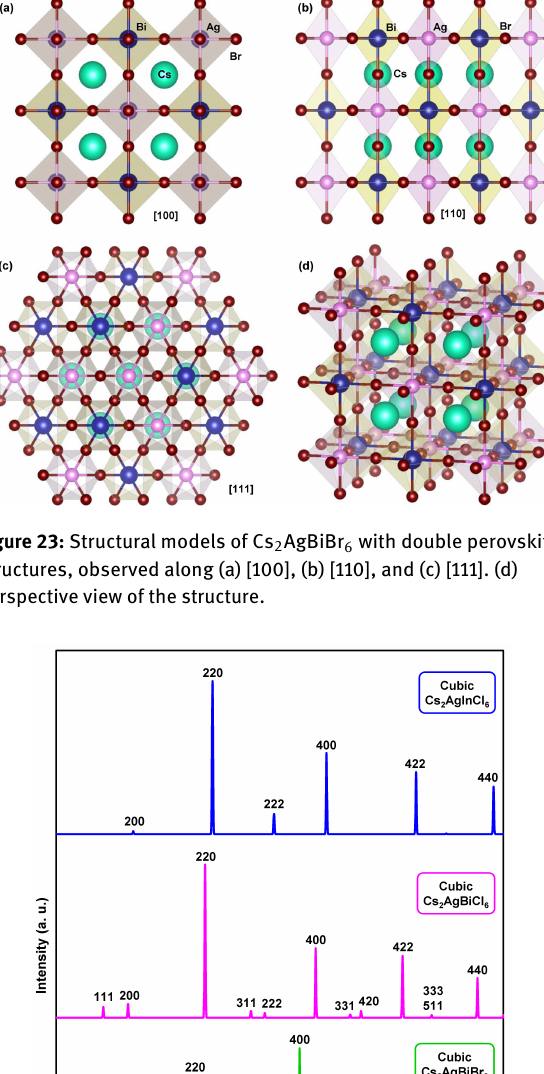
MA + ions can be substituted at the Cs site, and struc- tural models of MA 2 KBiCl 6 double perovskite structures observed along [001] and [100] are shown in Figure 25(a) and 25(b), respectively, in which hydrogen atoms are omit- ted. Calculated X-ray diffraction patterns of Cs 2 NaBiCl 6 , Figure 26. If the Cs + ions are substituted by the MA + ions,